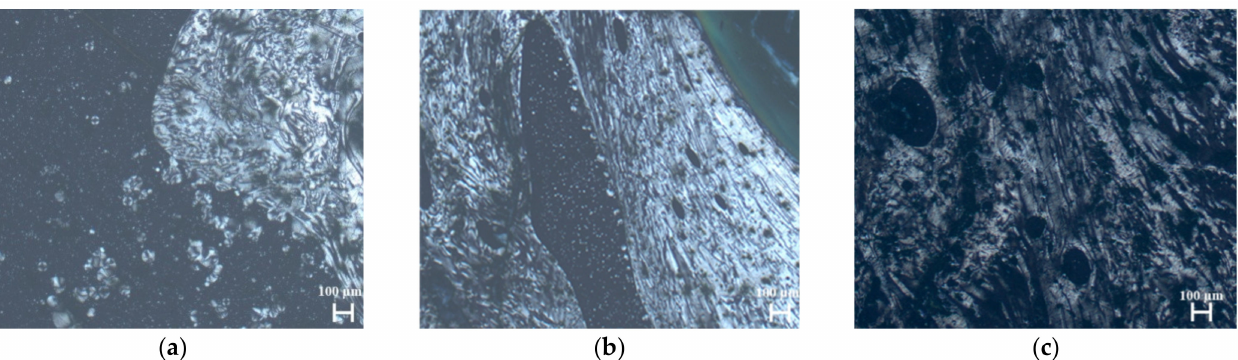
Figure 6. The photographs of the coke mesophases obtained in the polarized light, scale 100 µ m: ( a ) coke produced from the low-sulfur gasoil ( b ) coke produced from the gasoil fraction boiling at 400–450 ◦ C and ( c ) coke produced from the gasoil high-boiling fraction (>450 ◦